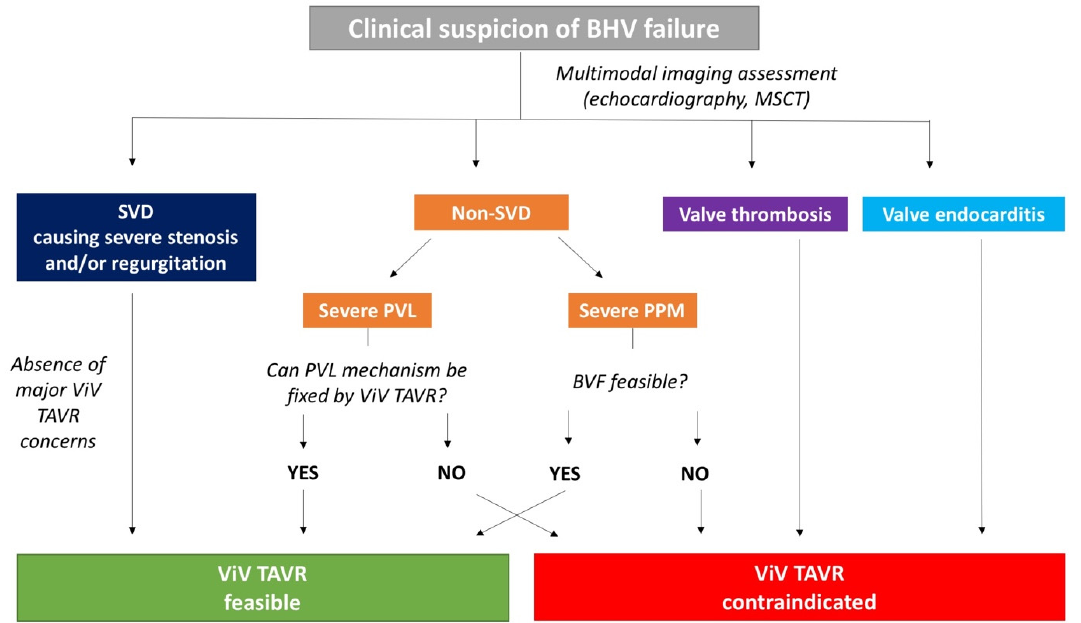
Figure 2. Practical diagnostic and therapeutic algorithm in case of BHV failure suspicion . BHV: